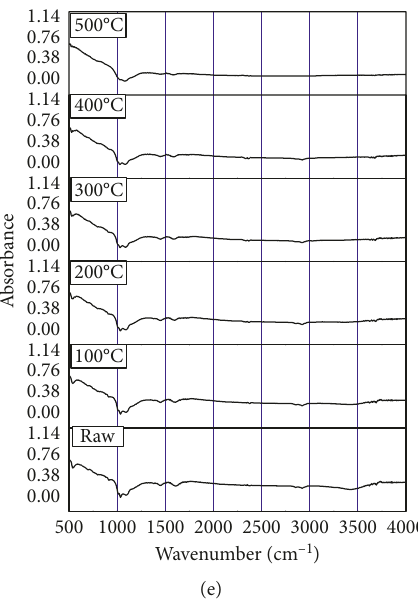
Figure 4: In situ infrared spectra of five coal samples at different temperatures: (a) SX; (b) KL; (c) HN; (d) HB; (e)